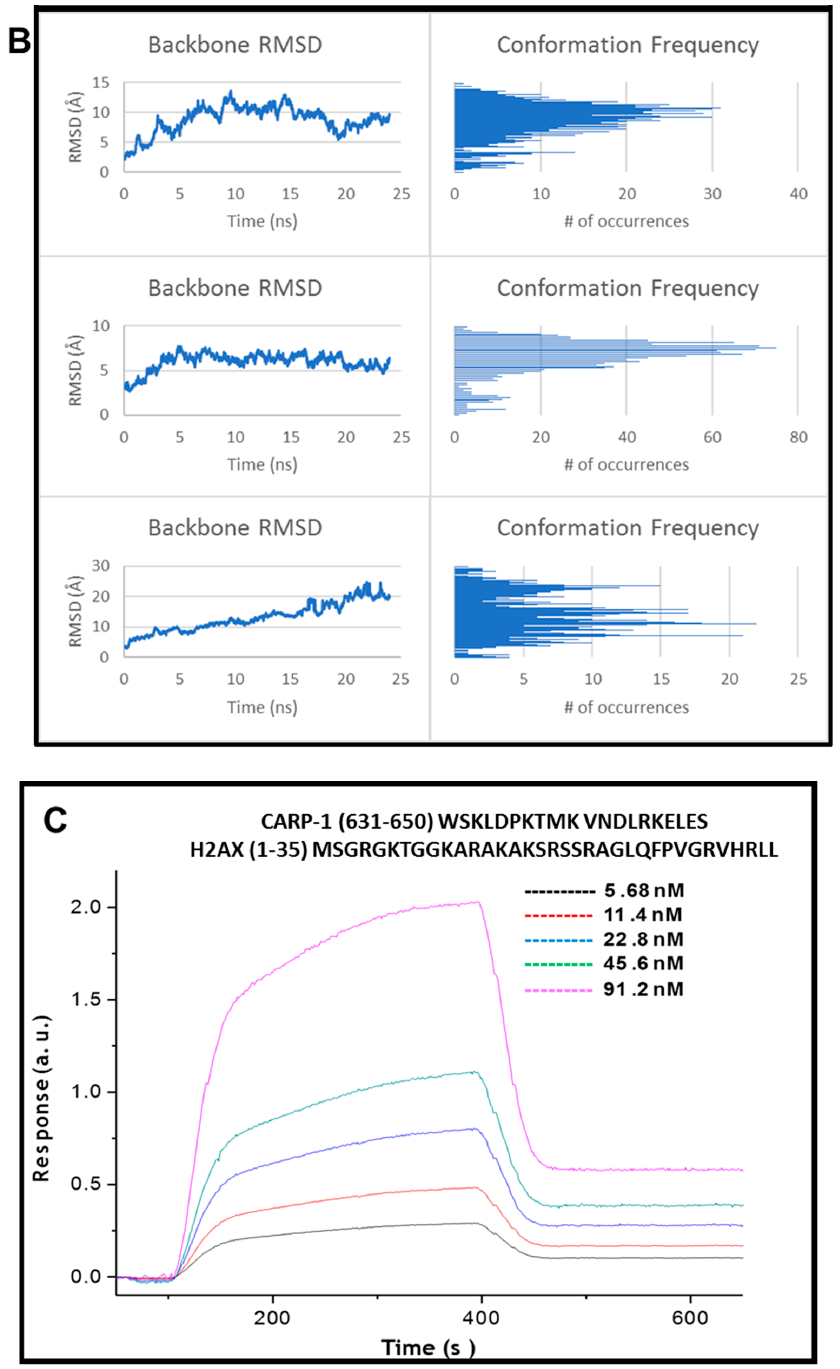
Figure 6. Computational analyses of H2AX (1–35) binding with CARP-1 (631–650). Backbone RMSD calculations and conformation frequency analysis for the three poses (top, middle, and lower boxes) of the docked CARP-1 (model A)/H2AX complex ( A ), and CARP-1 (model B)/H2AX complex ( B ). Each analysis was completed over 24 ns of simulation for each complex. ( C ) Surface plasmon resonance sensogram showing binding of noted CARP-1 and H2AX peptides (inset) as detailed in Section 2.